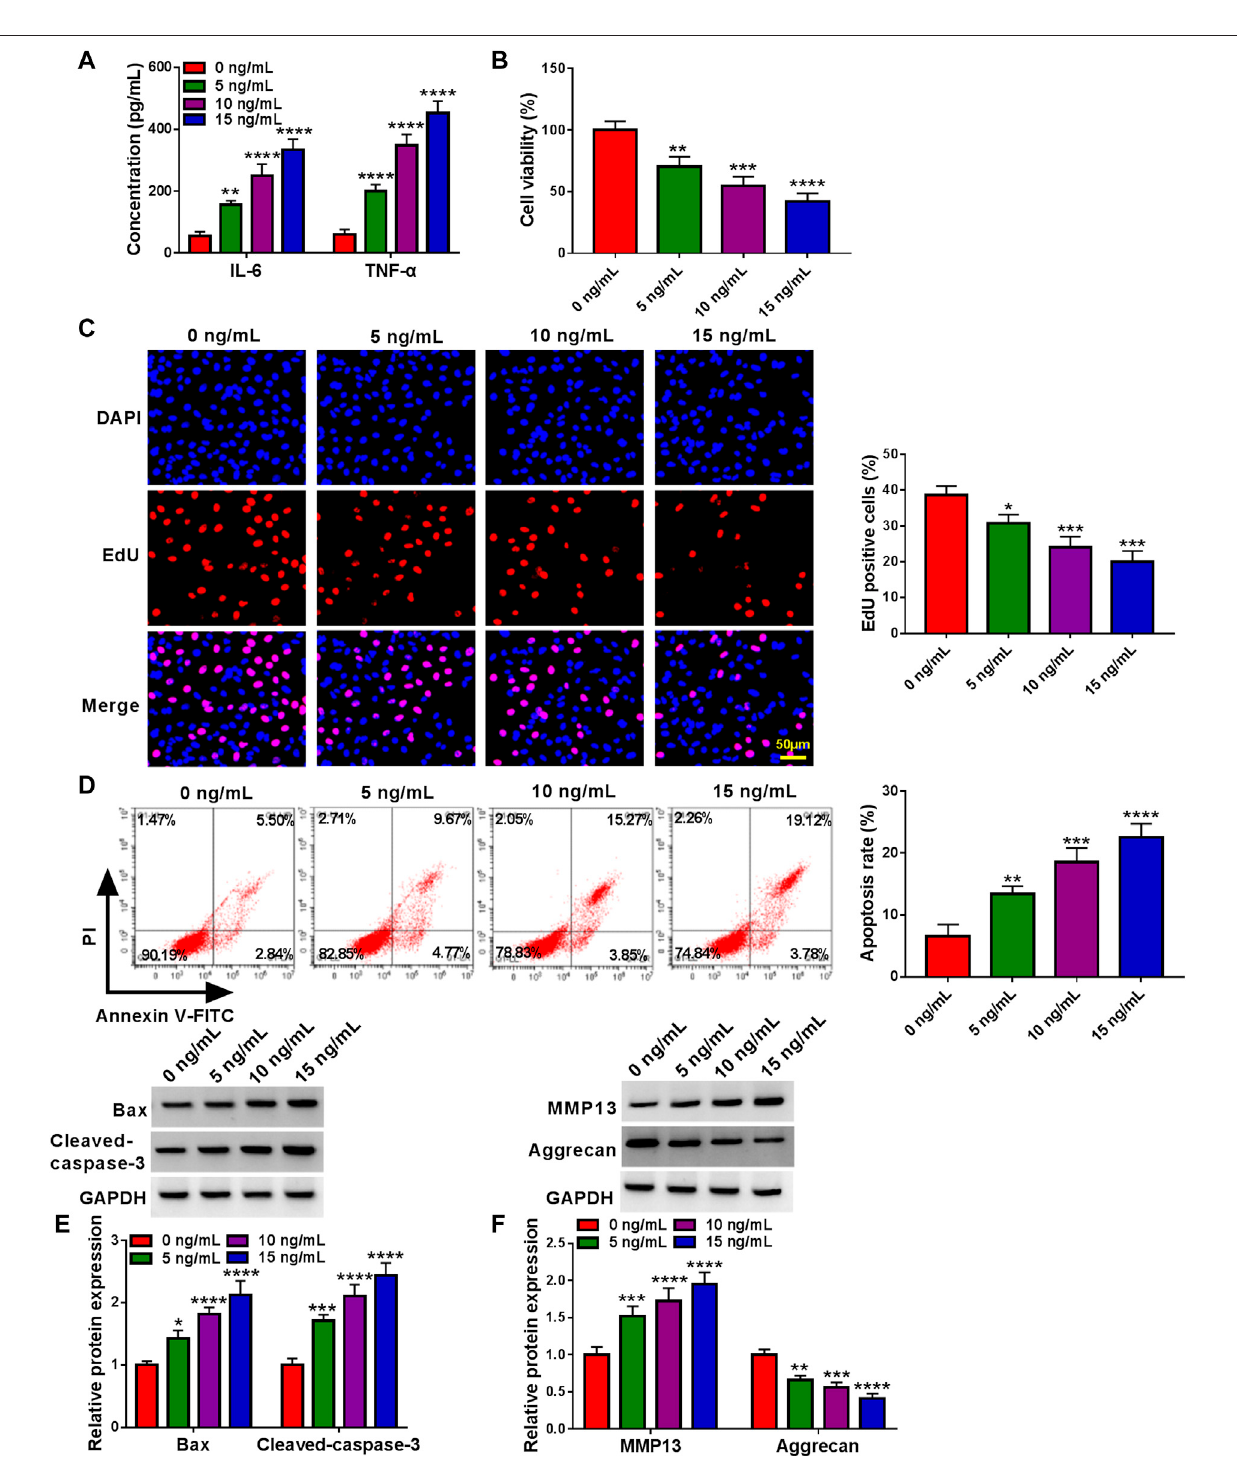
FIGURE1| Effects ofIL-1 β onin fl ammation, proliferation, apoptosis, and ECMdegradation ofchondrocytes. CHON-001cells weretreated with0,5,10or 15 ng/ ml IL-1 β for 24 h. (A) Concentration of cytokines (IL-6 and TNF- α ) in CHON-001 cells ’ culture medium of different groups was measured by ELISA Kit. (B) CCK-8 assay wasapplied toexaminecellviabilityintreatedCHON-001cells. (C) EdUassaywascarriedouttodetectproliferativecellsintreatedCHON-001cells. (D) Flowcytometry assay was performed to determine apoptosis rate in treated CHON-001 cells. (E,F) Bax, Cleaved-caspase-3, MMP13, and Aggrecan were measured using western blot assay in treated CHON-001 cells, and GAPDH was used as a loading control. These results were presented as the mean ± (SD), n = 3. *, **, ***or **** indicates p < 0.05, p < 0.01, p < 0.001, or p < 0.0001 relative to the 0 ng/ml IL-1 β groups.